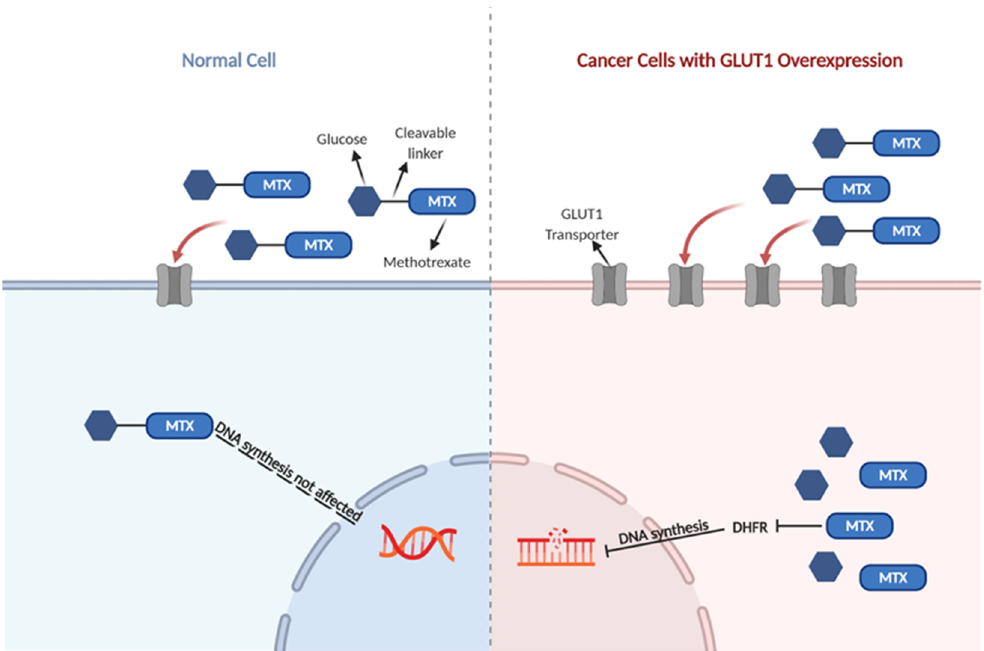
Figure 1. Cellular transport of glucose–methotrexate conjugate (GLU–MTX) in healthy and cancer cells with GLUT1 overexpression. The intracellular cleavage of acid-labile bonds in the acidic environment of cancer cells results in controlled release of MTX, which inhibits dihydrofolate reductase (DHFR) and leads to cell death. In healthy cells, no major effect in DNA synthesis is observed.